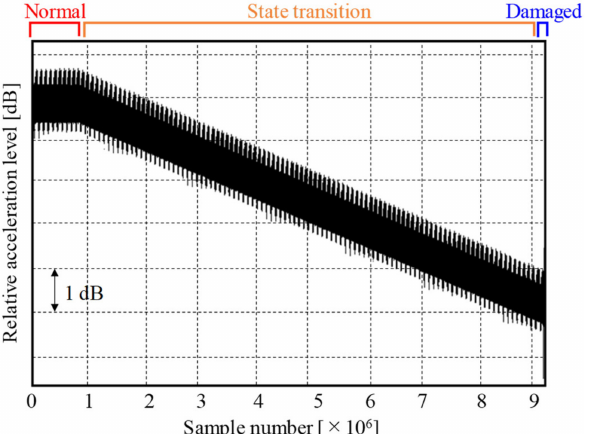
Figure 24. Simulated time-series data for vibration in the 1378 Hz band over 870 days: In these data, the energy level decreases monotonically by approximately 5 dB over the 780-day period.